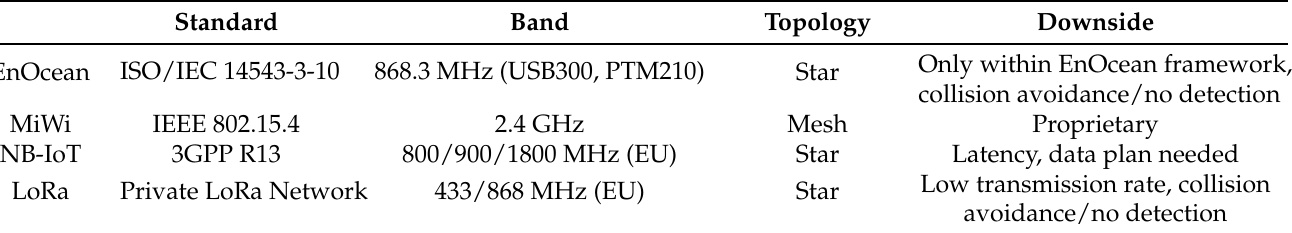
Table 5. Communication protocol comparison 1.